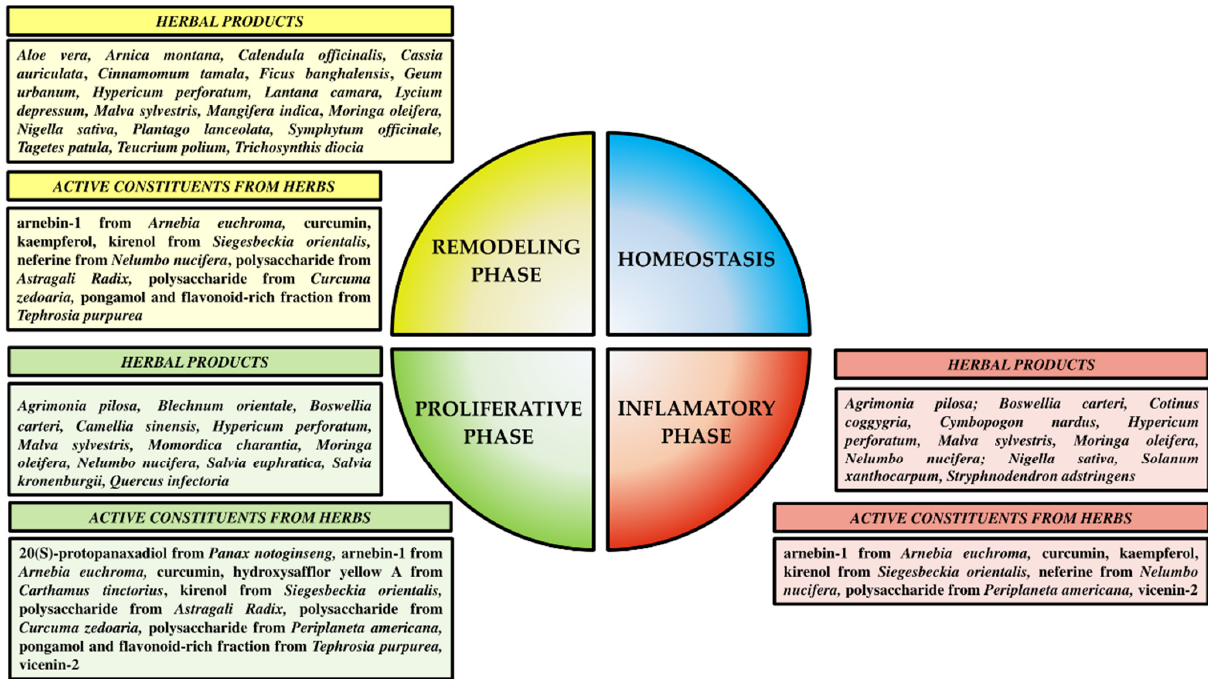
Figure 2. Influence of herbal products and their active constituents on the phases of diabetic wound healing.